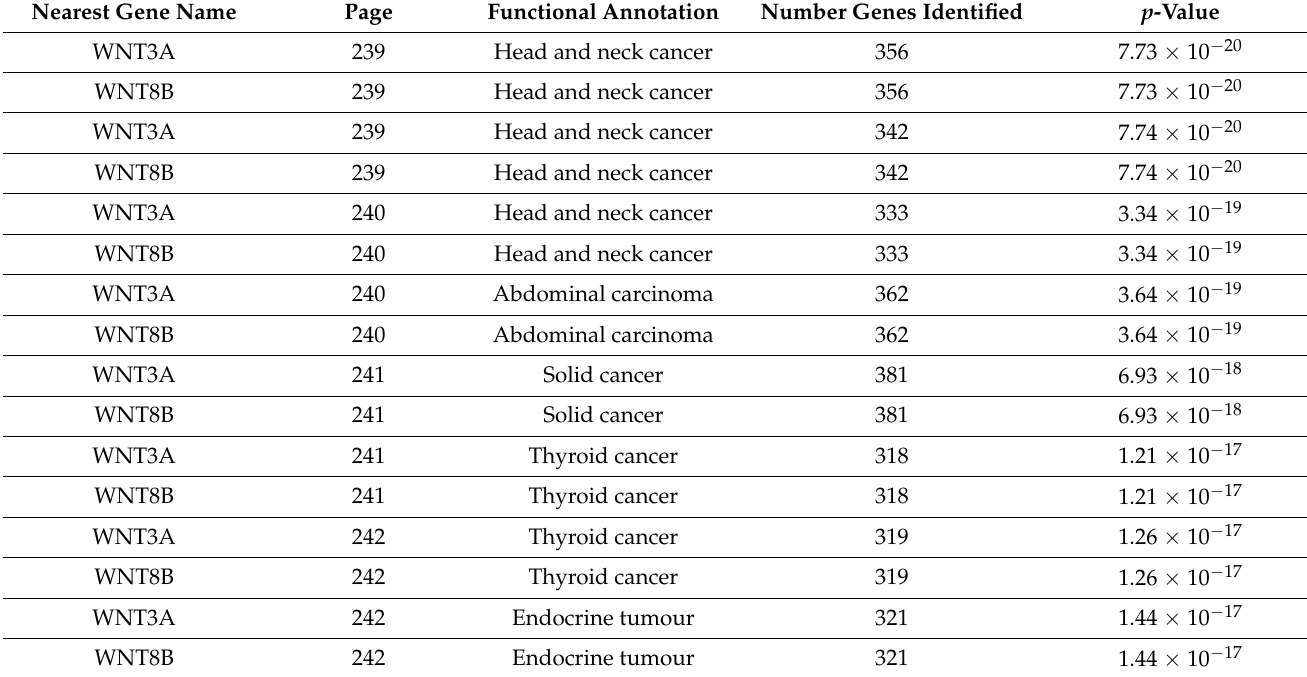
Table 20. EWAS Hits from Schrott Dataset for Significantly Differentially Methylated Regions for. Major Genes of Nephrogenesis II—Wnt’s.